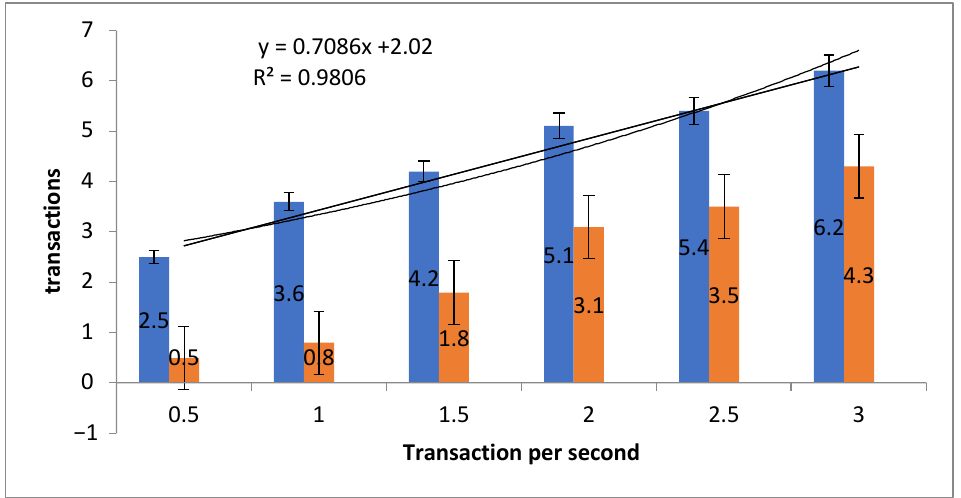
Figure 10. Comparison of transaction speed between PoW and PoS. σ √ SE = (7) n A Standard Error ( SE ) is calculated (Equation (7)) where SE represents the standard deviation of the transactions and total number n of transactions per second. The standard deviation shows the variability and dispersion of the transactions. The SE of PoW is ± 0.86 and PoS is ± 1.54, indicating that the mean value of transactions is close to the actual mean value and that, relatively, the error rate of PoW is less than